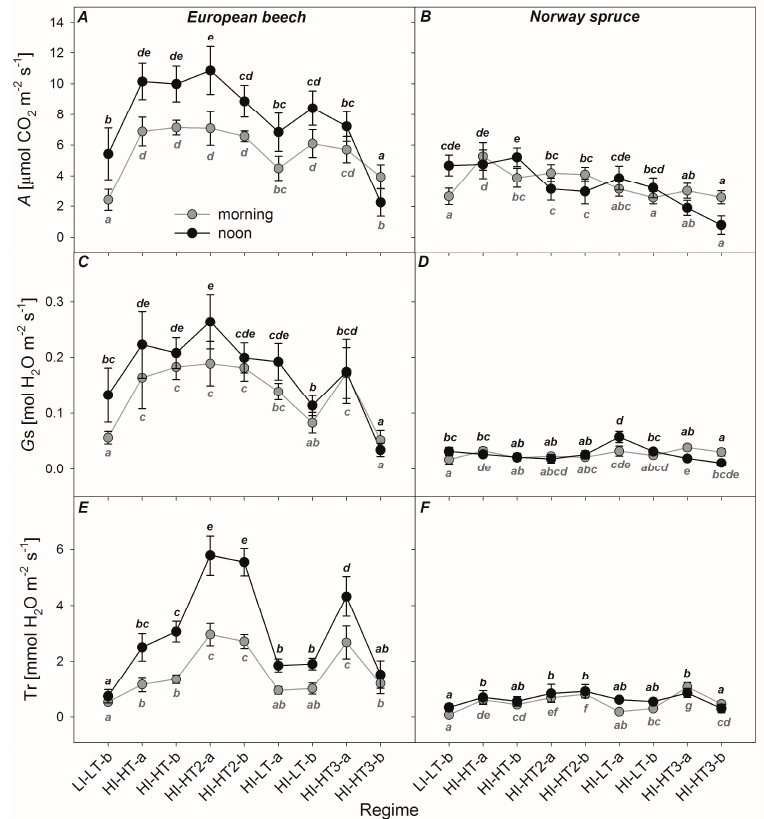
Figure 6. Changes in the rate of CO 2 assimilation ( A , ( A , B )), stomatal conductance ( G s, ( C , D )), and transpiration ( Tr , ( E , F )) in response to five consecutive regimes of photosynthetically active radiation (PAR) intensity and temperature (LI–LT, HI–HT, HI–HT2, HI–LT, and HI–HT3). Lowercase letters in the regime labels indicate data from measurements at the beginning (a) and end (b) of acclimation to the given regime. Data from morning (grey lines and points) and noon (black lines and points) measurements are shown. Means (points) and standard deviations (error bars) of the measurements are presented ( n = 6). Different letters indicate significant differences between the means of the noon values ( p < 0.05; Tukey’s post hoc test).